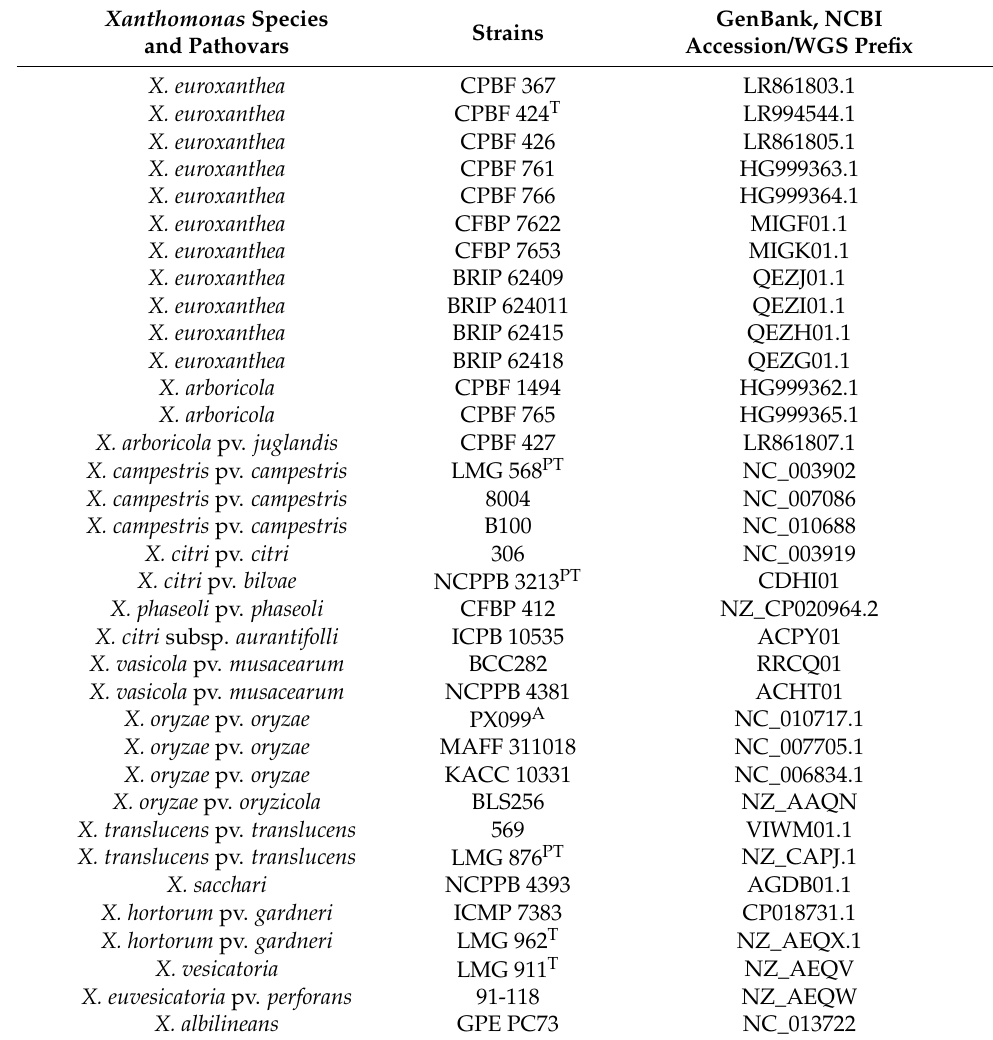
Table 1. Bacterial strains used for MaGe synteny analysis to retrieve Xanthomonas euroxanthea specific coding sequences